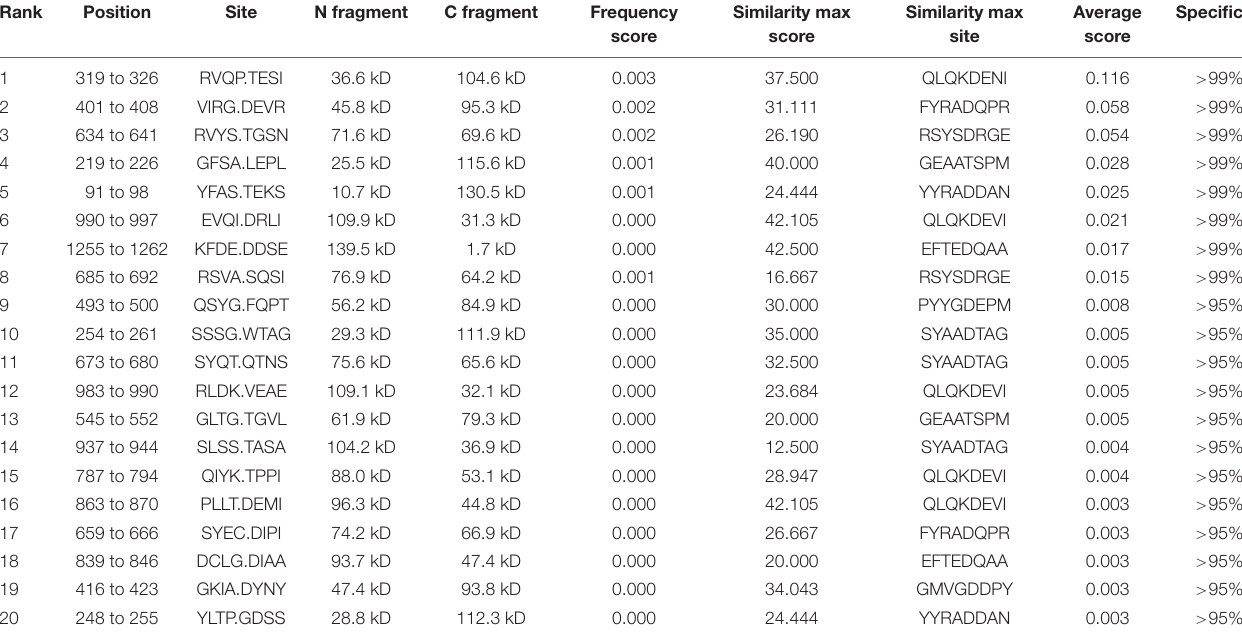
TABLE 6 | Top 20 cleavage sites predicted with SitePrediction ranked by average